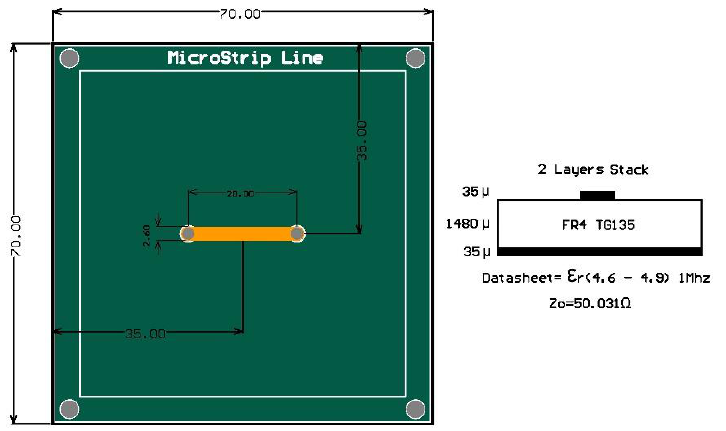
Figure 4. Structure and dimensions of the characterization setup elements. Features of the microstrip line PCB employed to generate the near-field signal to be measured by the NFP.